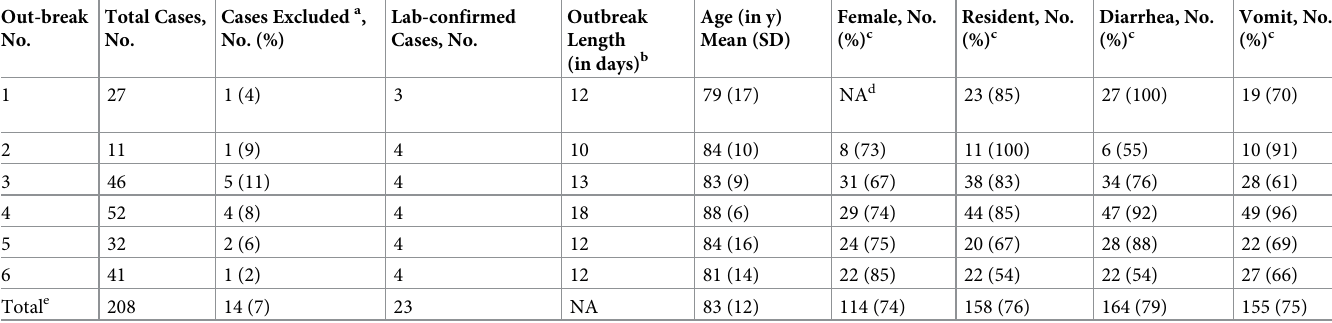
Table 1. Characteristics of analyzed nursing home norovirus outbreaks; South Carolina, 2014–2016. Out-break